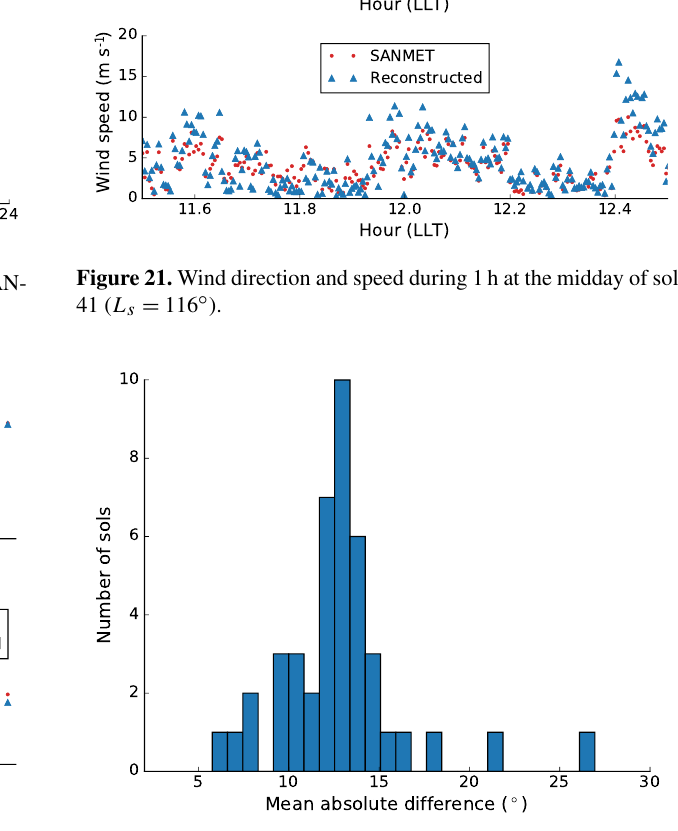
Figure 20. Wind direction and speed during a 6min time period from the forenoon of sol 3 ( L s 98 ◦ ). =